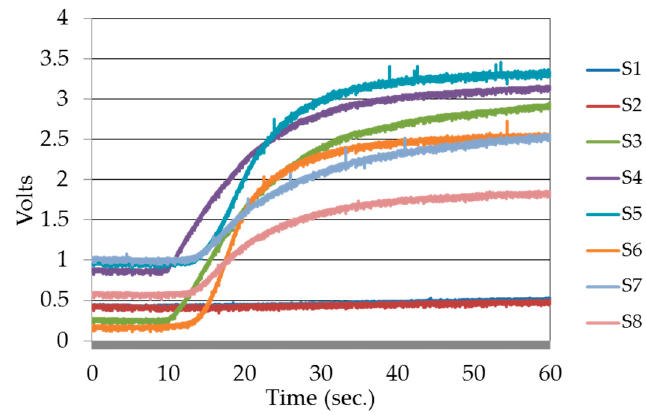
Figure 7. Time versus voltage responses of eight sensors to rotten sapodilla. S1 to S8 are sensor labels as listed in Table 1.